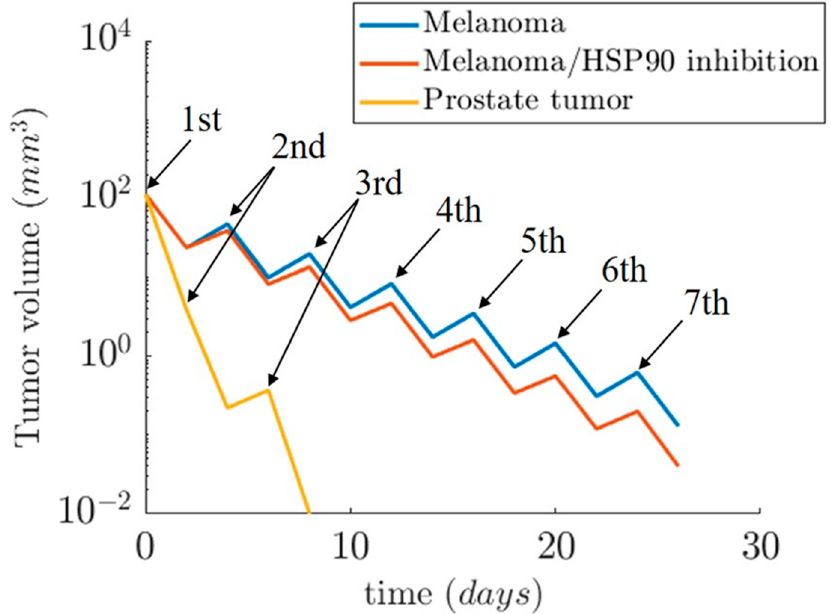
Figure 15. Estimated results for tumor shrinkage upon hyperthermia complete treatment (3–7 sessions) for two cancer types. The therapeutic sessions for Melanoma were repeated every 4 days. In the Prostate tumor, the time interval between the first two sessions was 2 days, while the interval between the 2nd and 3rd session was 4 days. For Melanoma, the expected values considering HSP90 inhibition were included.